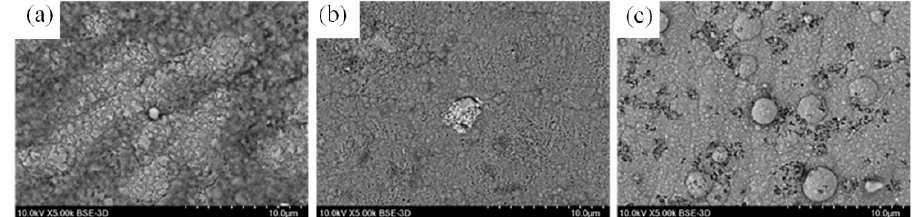
Figure 13. SEM images of Ni (a), Ni-CeO 2 ( b ), and Ni-TiO 2 ( c ) coatings after 3.5 months of exposure to 0.5 M NaCl.